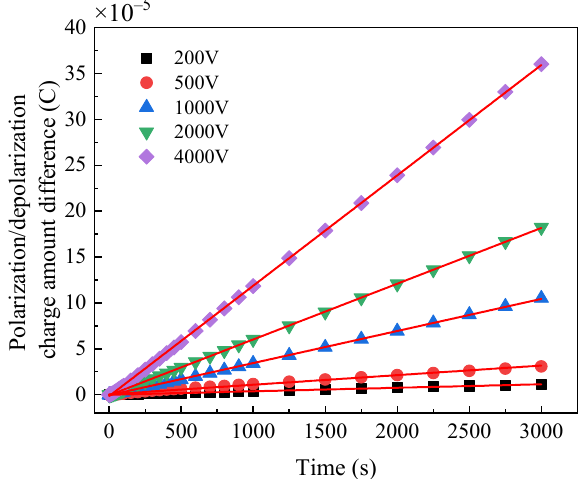
Figure 15. Polarization/depolarization charge amount difference curve of damped cellulose polymer paper bushing.